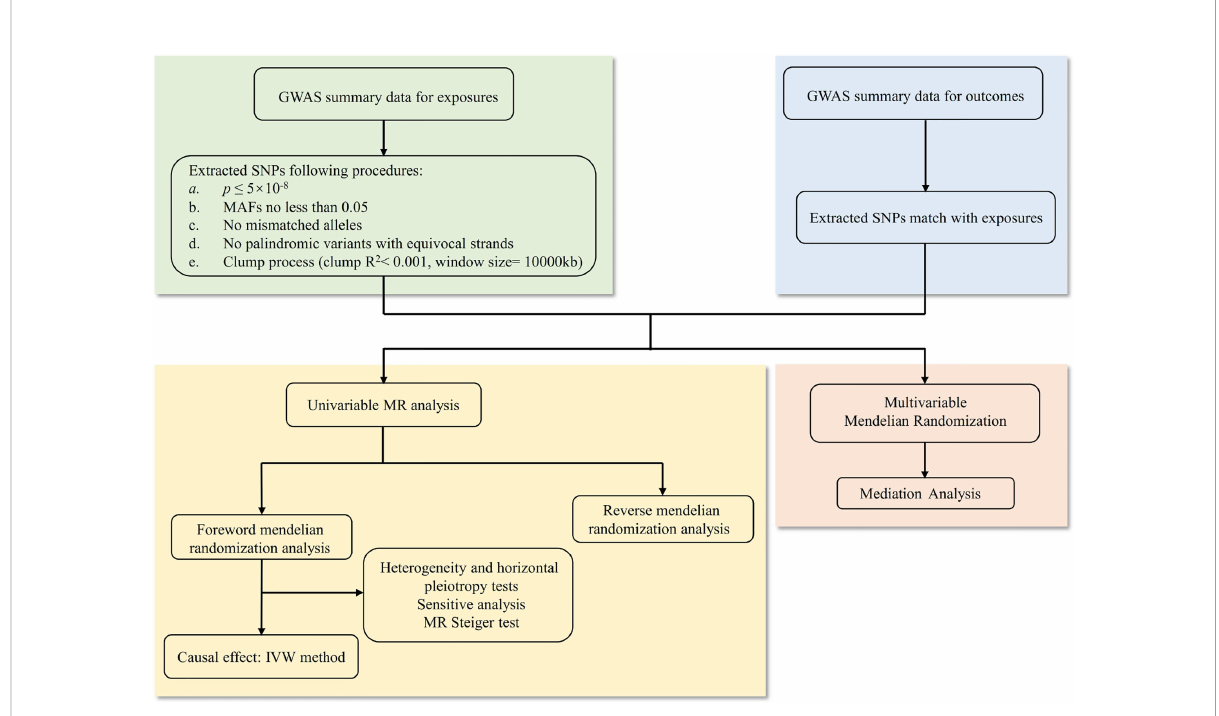
FIGURE 1 The whole work fl ow of MR analysis. MR, Mendelian randomization; GWAS, genome-wide association studies; SNPs, single nucleotide polymorphisms; MAFs, minor allele frequencies; IVW, inverse-variance